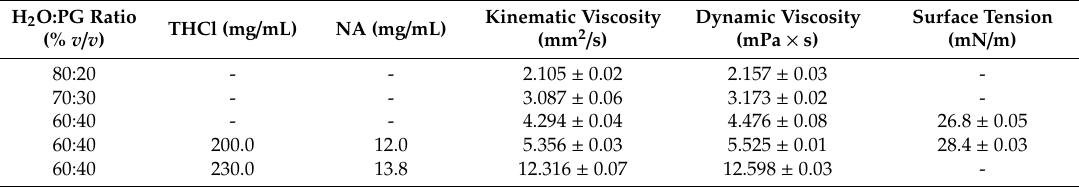
Table 2. Viscosity and surface tension measurements of the liquid inks.